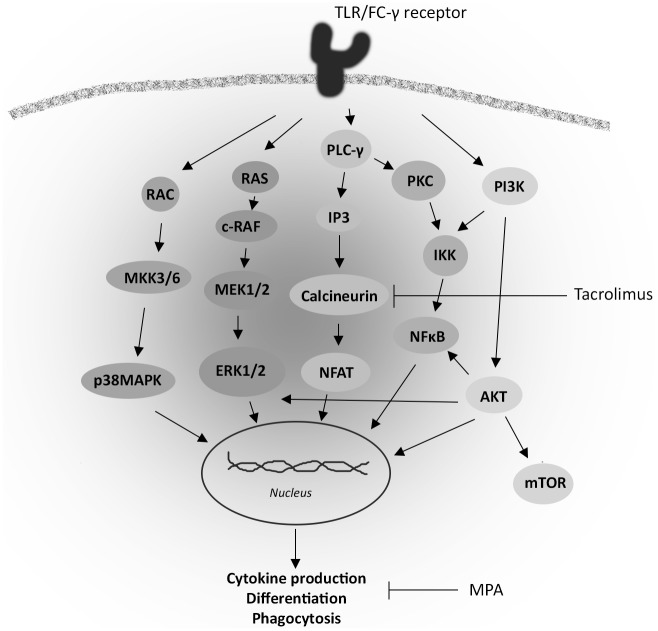
Simplified overview of intracellular signaling pathways involved in monocyte activation.After toll like receptor (TLR) or FC-γ receptor activation the MAPK, Akt and NFAT pathways are activated upstream. The phosphorylation of the intracellular signaling proteins leads to the activation of transcription factors, such as CREB and NF-κB p65, which after activation leads to gene transcription. This process determines the function of monocytes including phenotypic differentiation, cytokine production and phagocytosis.